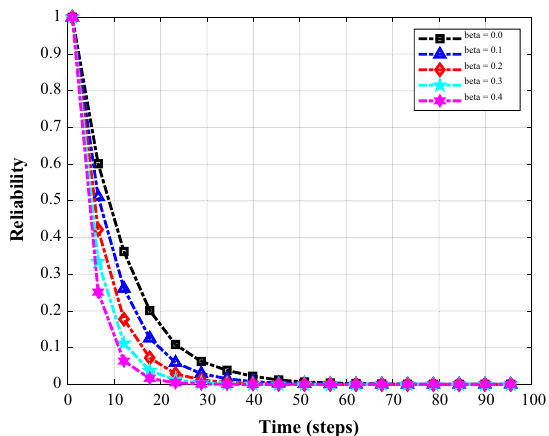
Fig. 12 Reliability performance at medium system diagnostic coverage level and 50% repair efficiency